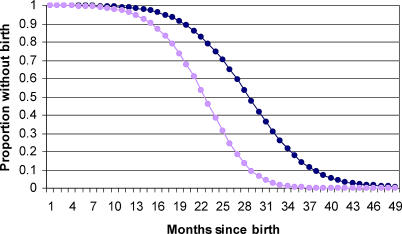
Model of Risk of Birth over Time by Water AccessData presented are controlled for child survivorship, mother's age, parity, religion, socioeconomic status, and village for 1,526 women. Purple curve, access to taps; blue curve, no access to taps.